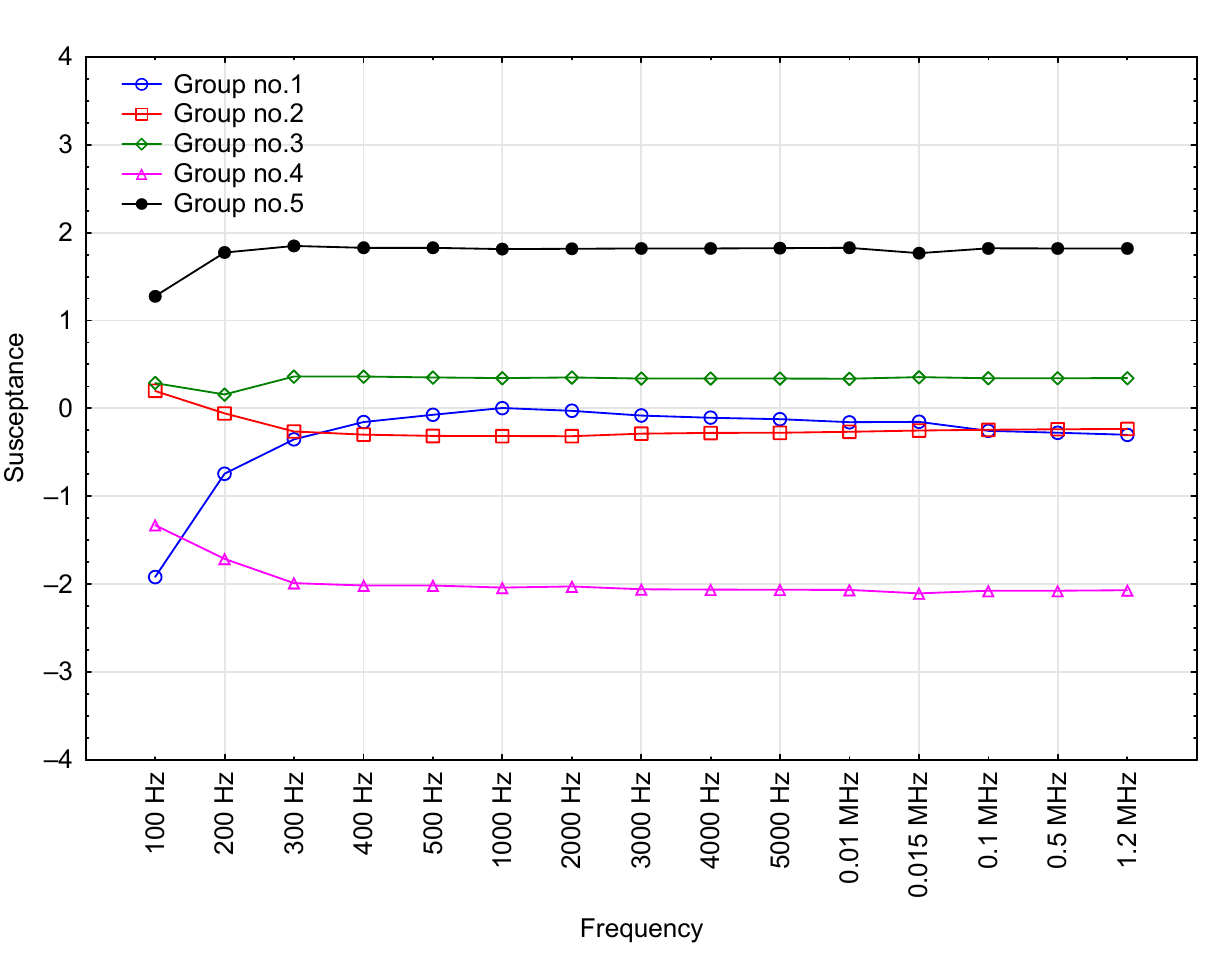
Figure 12. Effect of test voltage frequency on the average susceptance value of engine oils in each cluster (grouped by k-means). Table 7. Assignment of the oils into the different groupings according to similarity in susceptance values.